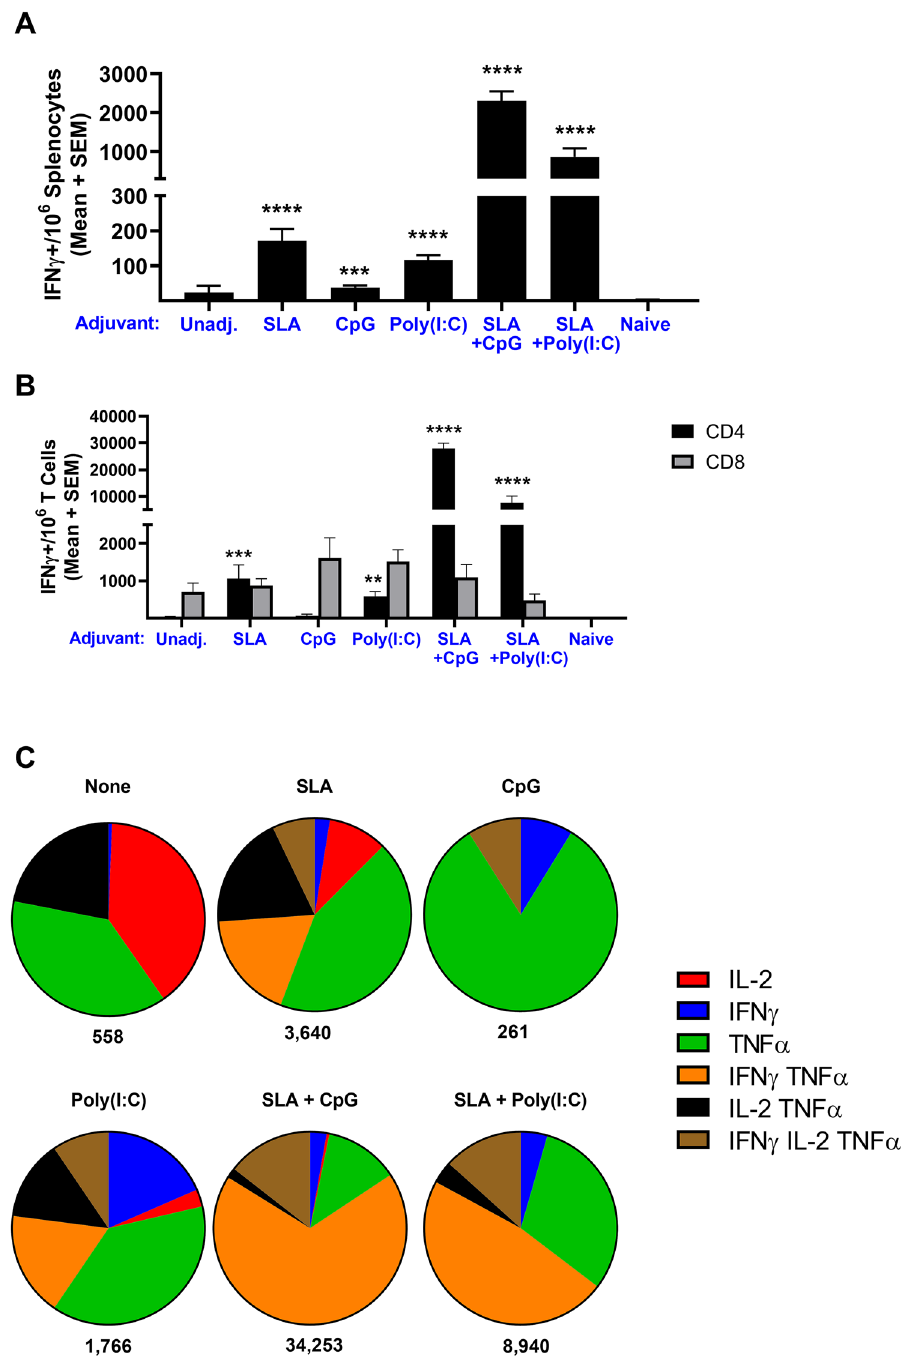
Figure 5. Cellular immune response with SmT1-based vaccine formulations adjuvanted with SLA, CpG and Poly(I:C) alone or in combination. C57BL/6 mice were immunized i.m. with 1 µg of SmT1 alone or with SLA, CpG and Poly(I:C) alone or in combination on Days 0 and 21. Splenocytes were harvested on day 28 and analyzed by IFN-γ + ELISpot (n = 10/group) when stimulated by spike peptide pools or media alone ( A ). Similarly, intracellular cytokine staining (ICCS; n = 5/group) was conducted on the splenocytes to measure levels of IFN-γ + CD4 + or IFN-γ + CD8 + T cells when stimulated by a spike peptide pools or media alone ( B ). Grouped data is presented as mean + standard error of mean. The frequency of cells expressing IFN-γ, TNF-α, and IL-2 alone or in combination as assessed by ICCS is displayed (median per group) with the total number of cytokine-positive cells per million CD4 + T cells indicated below the pie chart ( C ). Values obtained with media alone were subtracted from those measured in the presence of the peptide pool. Statistical significance of differences between the adjuvanted groups vs. the antigen alone control group is shown: **p < 0.01, ***p < 0.001 and ****p < 0.0001 by one-way ANOVA followed by Tukey’s multiple comparisons